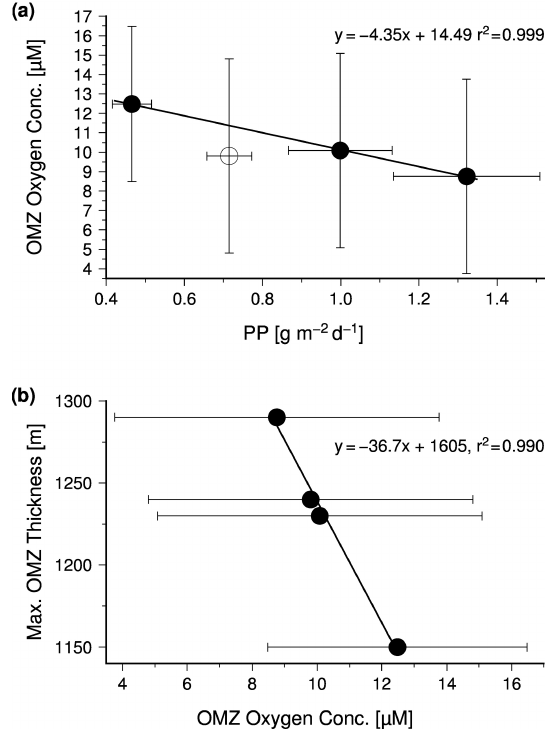
Figure 6. (a) The seasonal mean satellite-derived primary produc- tion versus the seasonal mean oxygen concentration within the Ara- bian Sea OMZ and (b) the seasonal mean oxygen concentration ver- sus the maximum OMZ